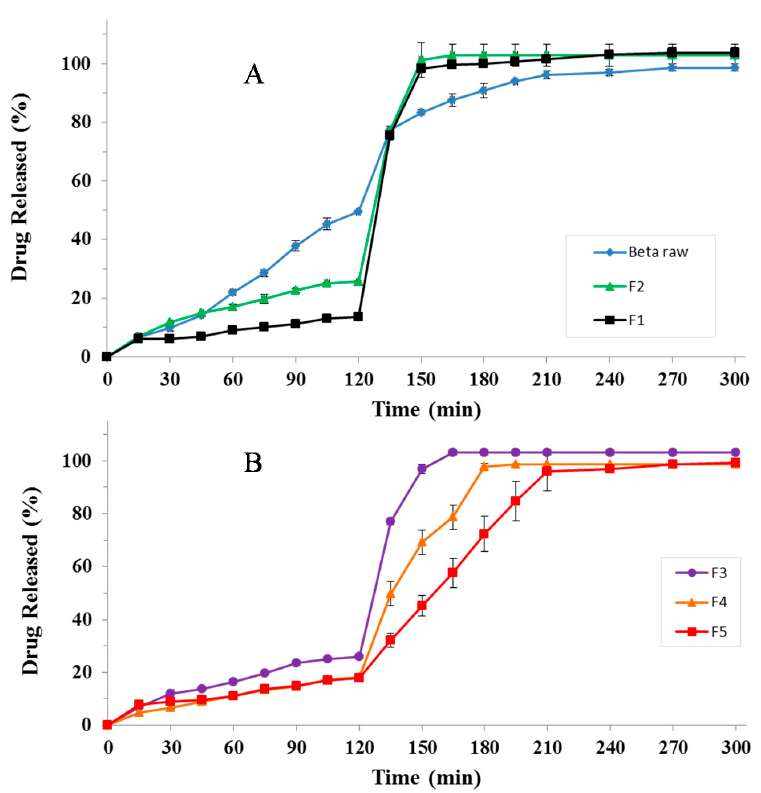
Figure 4. Release profiles of B raw material, formulations F1-F2 ( A ), F3, F4 and F5 ( B ). Mean ± SD ( n = 6).